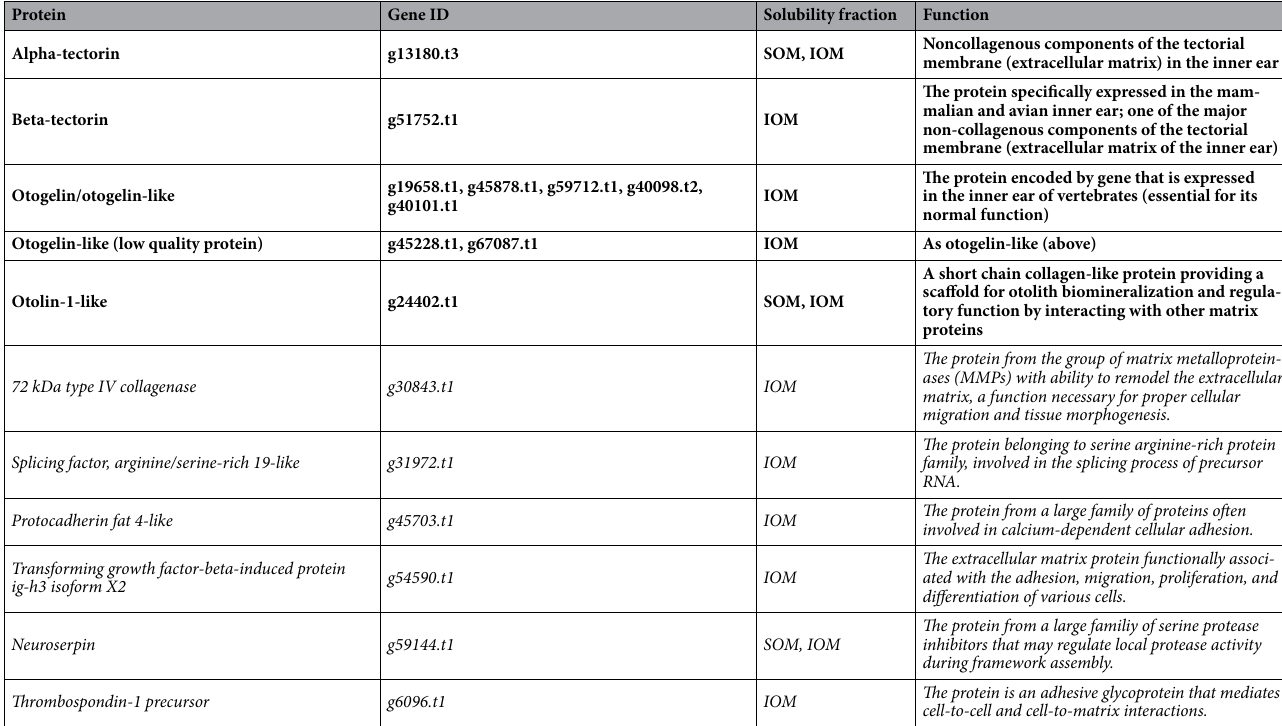
Table 2. Proteins sequenced from a fossil Phycis tenuis otolith by LC–MS/MS. All proteins were also identified in modern otoliths of Phycis phycis (Supplementary Table S4). The bolded text highlights proteins specific